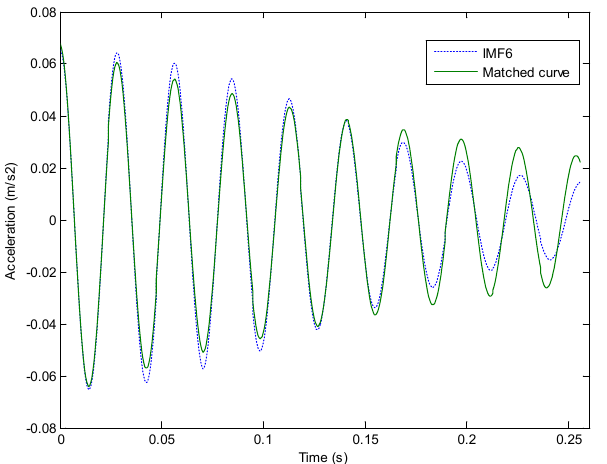
Figure 13. Corresponding to Figure 11, the fitting curve used in the ARMA model. Table 2. Comparison of the modal frequency identification results (Hz).